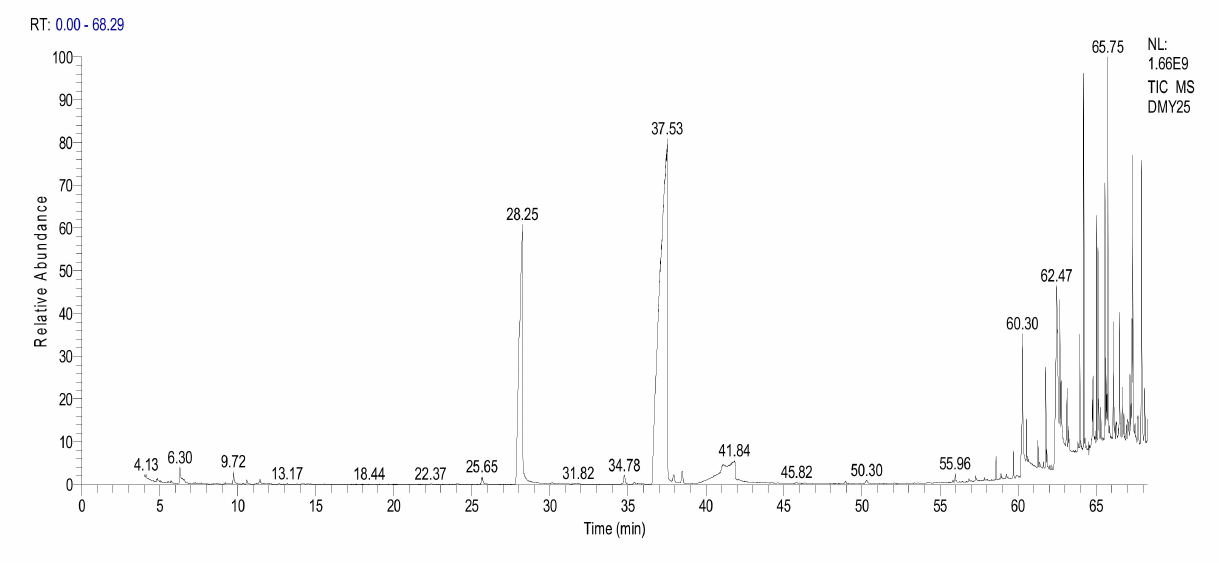
Figure 3. GC-MS qualitative data of value vanilla essential